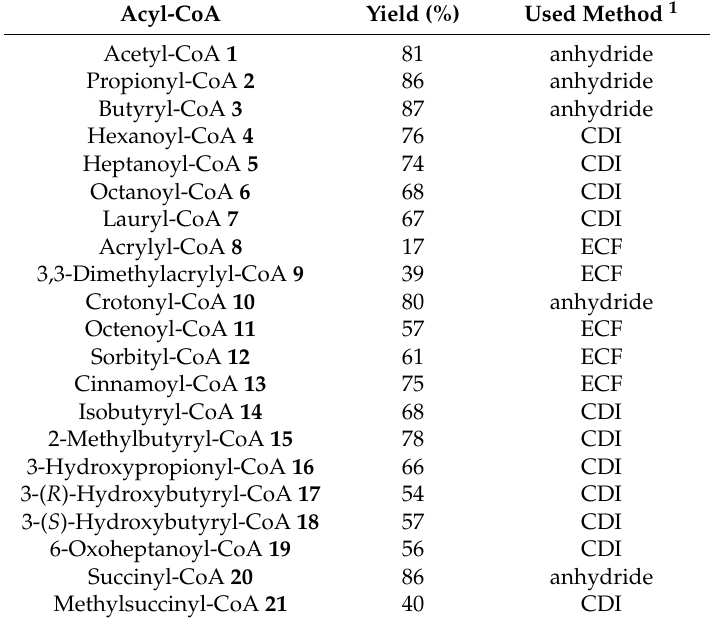
Table 1. Chemically synthesized CoA-thioesters. Products were confirmed by HPLC-MS. Yield was determined with HPLC-UV at 260